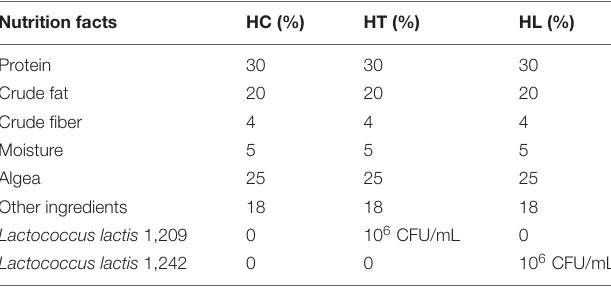
TABLE 1 | Composition of the basal commercial